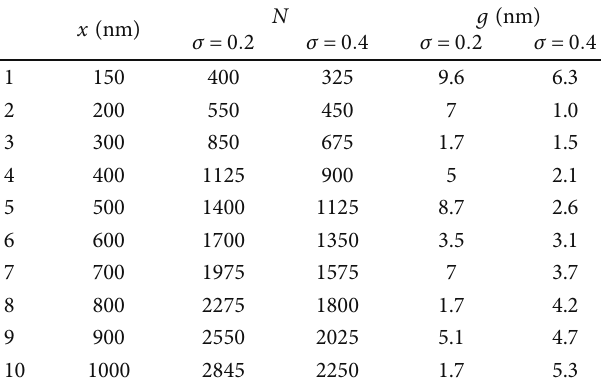
Table 2: Values of the gap ( g ) for a given degree of polymerization ( N ), density ( σ ), and initiator structures size ( x